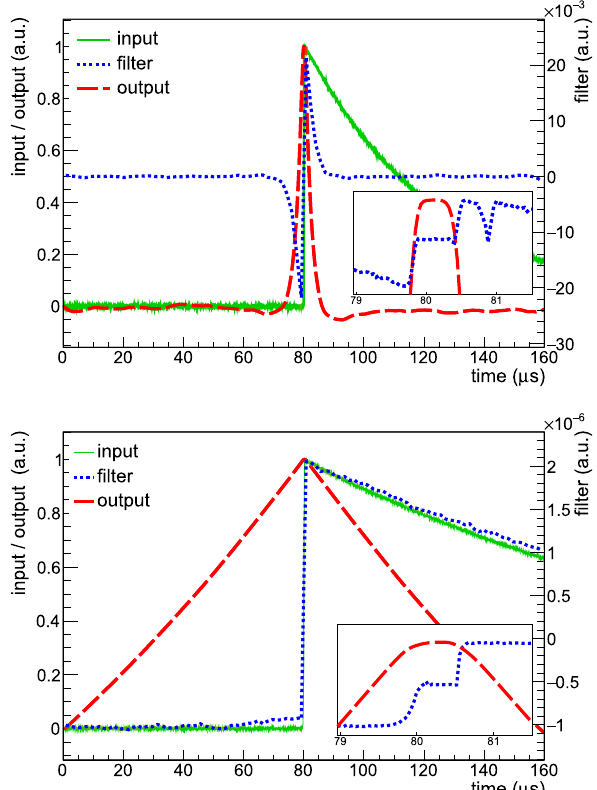
Fig. 11 The results of filter synthesis with added flat-top constraints for the two cases considered in the text, with insets better showing the